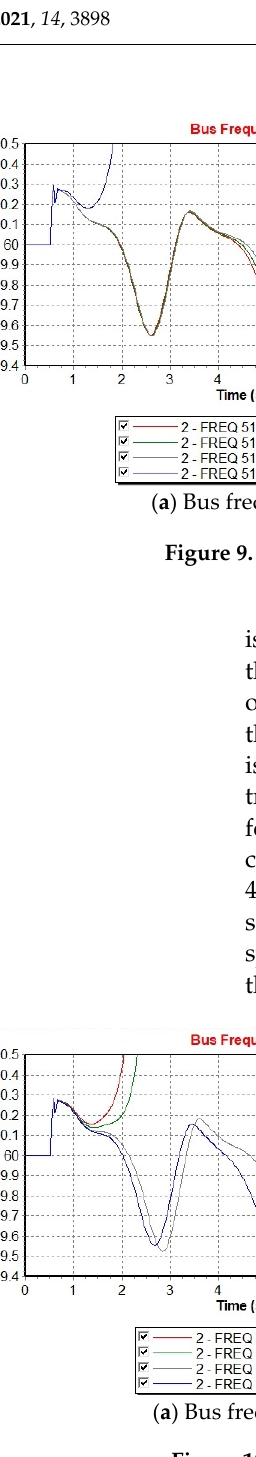
Figure 10. Performance of a frequency response BESS by varying the droop gain.